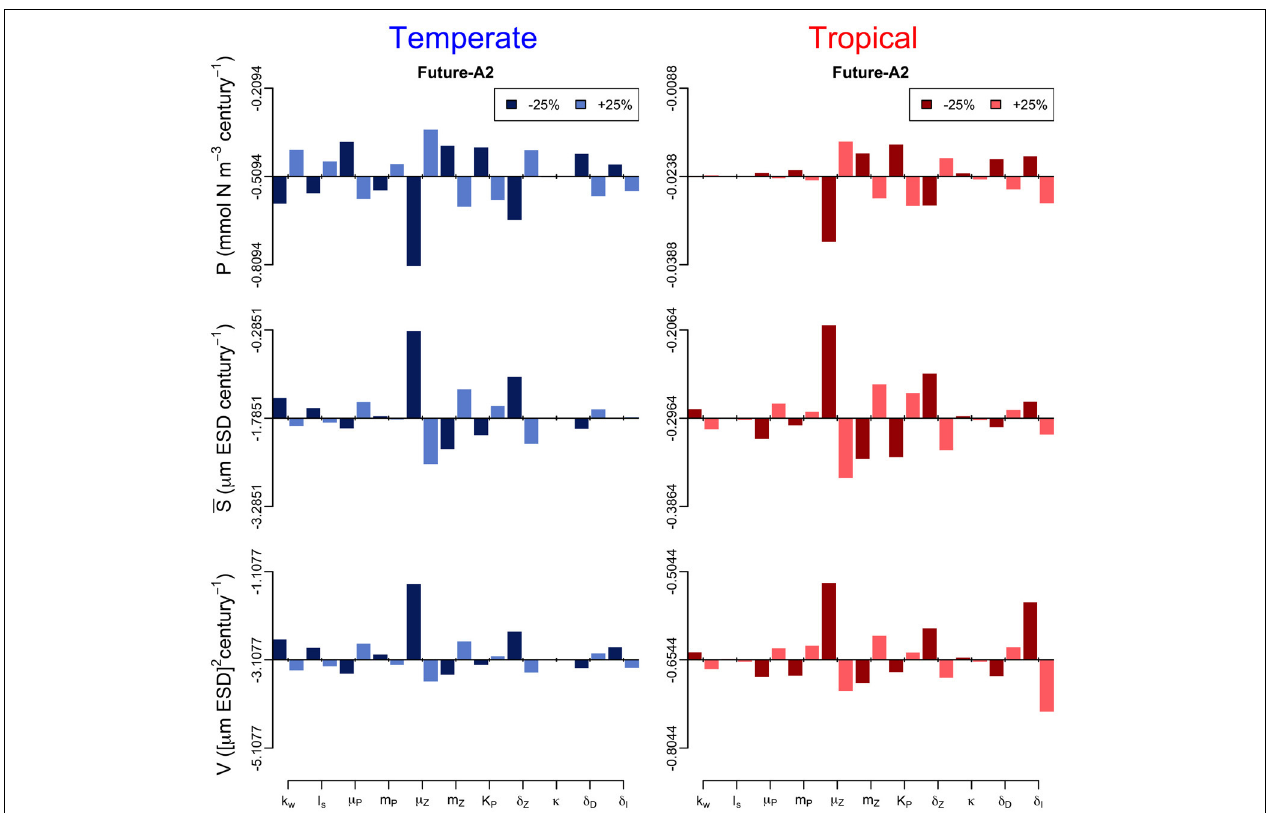
FIGURE 7 | Sensitivity analysis of the phytoplankton state variables (P, S, and V) to ± 25% changes in values of the model parameters for the future-A2 period. The origin of each panel corresponds to the magnitude of